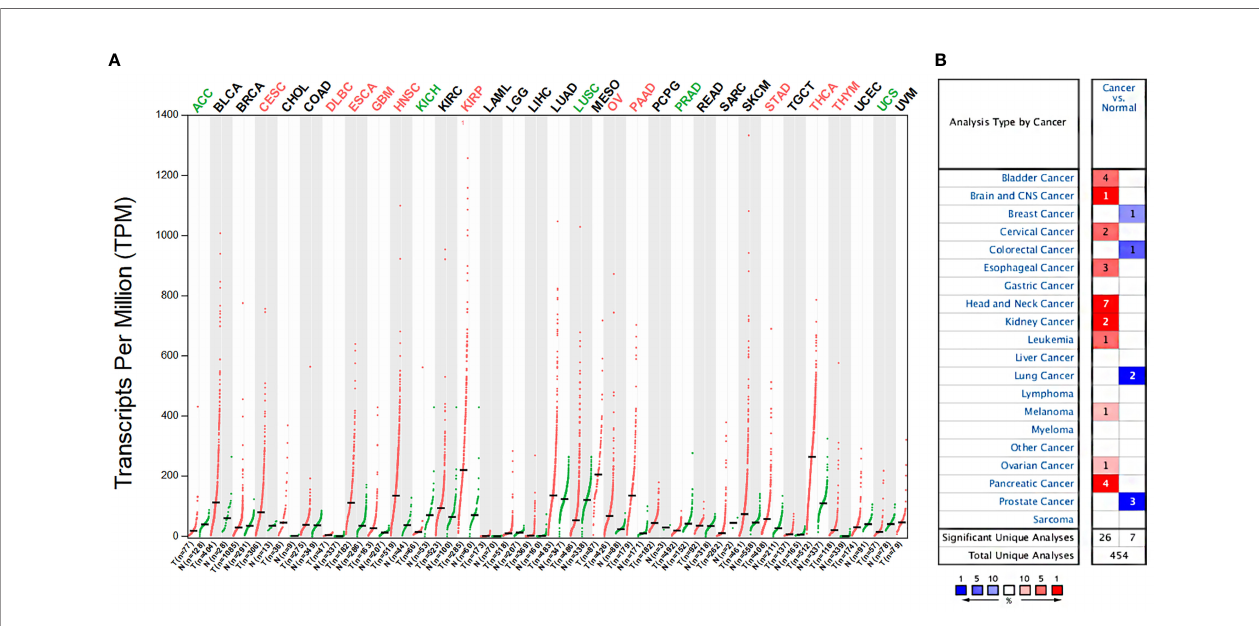
FIGURE 1 | ITGA3 mRNA expression levels in different types of human cancers. (A) The expression of ITGA3 in pan-cancer in The Cancer Genome Atlas (TCGA) database was obtained from GEPIA database. (B) The expression of ITGA3 in different cancers compared with normal tissues in the Oncomine